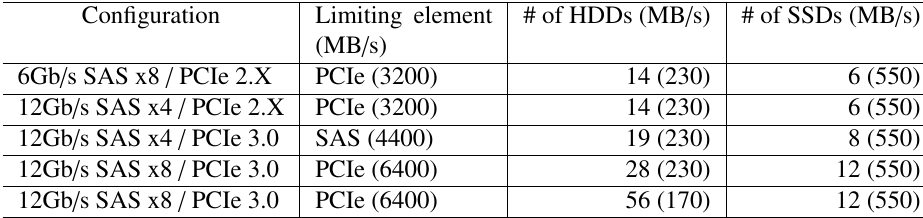
Table 2: Sample storage configurations showing the I / O rate limiting element and the number of drives supported at their peak throughput [9]. Note that SAS x4(x8) denotes the number of lanes embedded in one port of SAS HBA